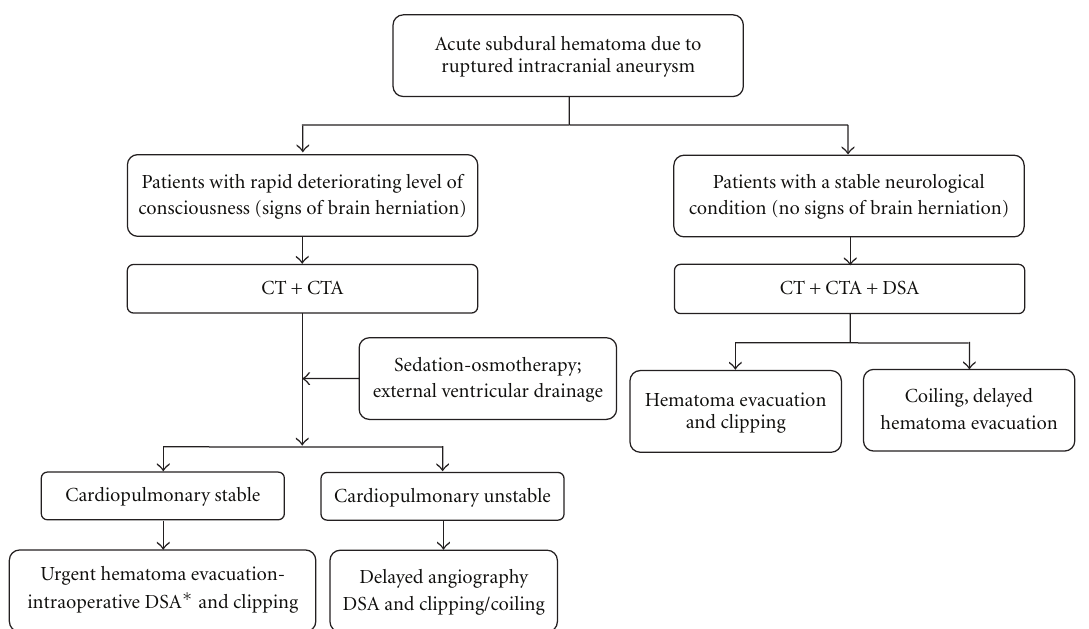
Figure 3: Illustrative schematic diagram of the protocol (management algorithm) for diagnosis and treatment of aneurysmal acute subdural